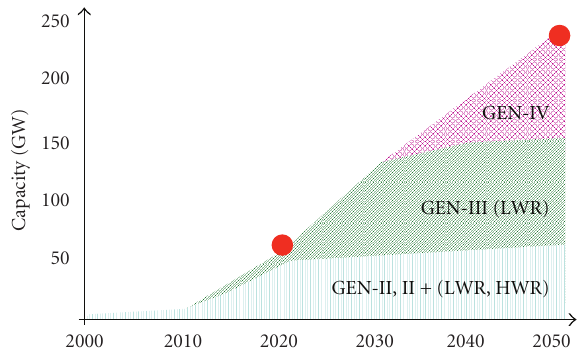
Figure 1: Expected nuclear power development in